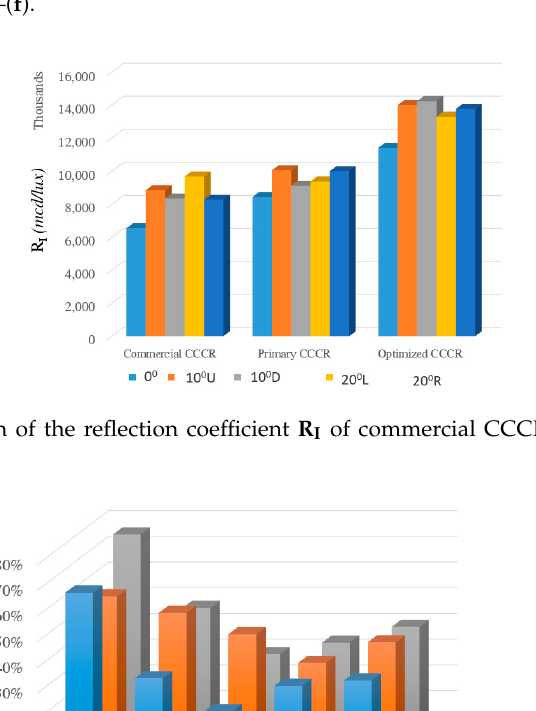
Figure 20. The prototyped SuperPin CCCR of the optimized design. Commercial CCCR